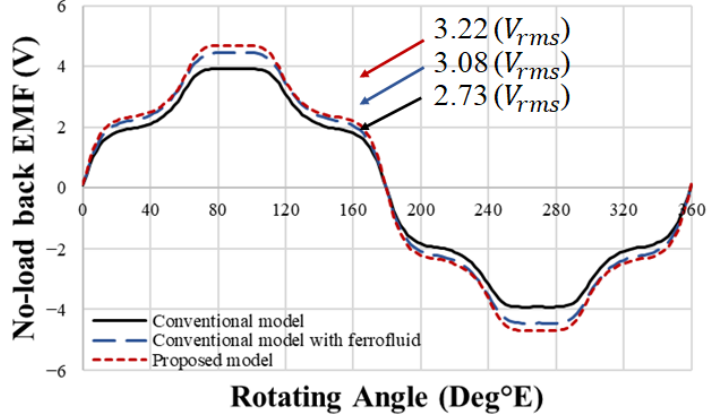
Figure 12. Comparison of the no-load back EMF (4000 rpm).